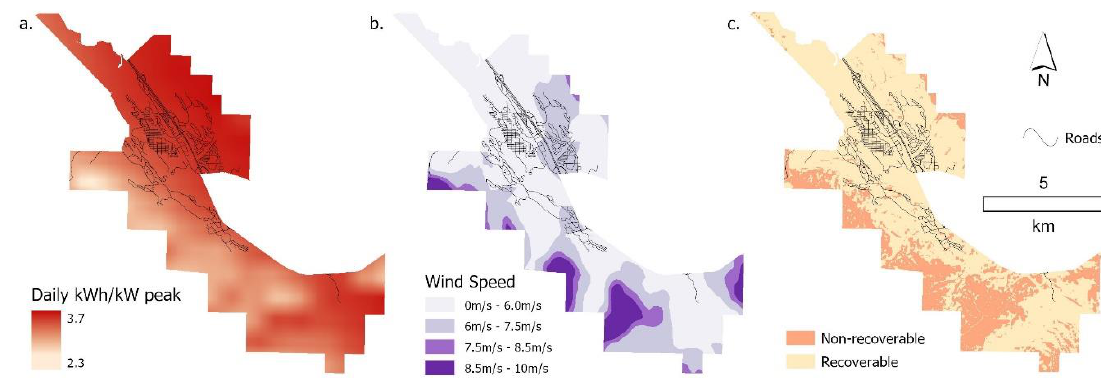
Figure 4. Theoretical resources of ( a ) solar PV input and ( b ) wind potentials; ( c ) technically recoverable potentials that consider the slopes and aspects.